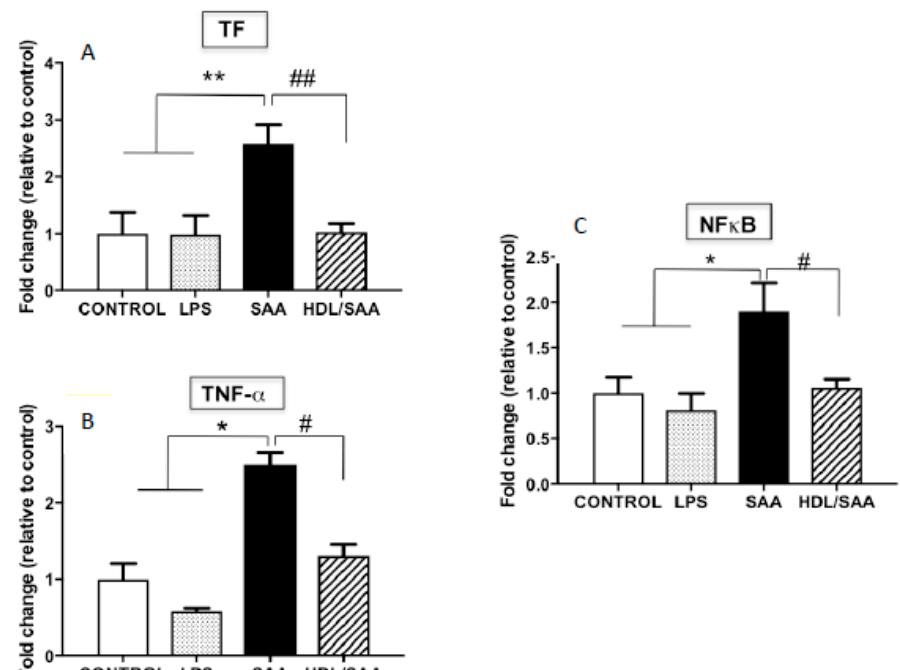
Figure 6. Relative gene expression of selected inflammatory cytokines (TF, TNF- α , NF κ B) in mouse hearts. Male ApoE − / − mice were allocated into 4 treatments arms and administered with vehicle (control), LPS, SAA alone, or SAA in combination with HDL. Mice were monitored for 4 weeks after commencement of treatment then sacrificed, and hearts were harvested and processed, as described in the methods section. The extent mRNA expression of TF ( A ), TNF α ( B ), and the transcription factor NF κ B ( C ) were determined in heart tissue homogenates by qPCR. Data represent mean ± SD of duplicate analyses from control ( n = 5), LPS ( n = 5), SAA ( n = 5), and HDL/SAA ( n = 5) mouse hearts. * Increased significantly relative to vehicle and LPS control groups. Decreased significantly compared to SAA alone group, ** p < 0.001, * p < 0.05, ## p < 0.001, and # p < 0.05.